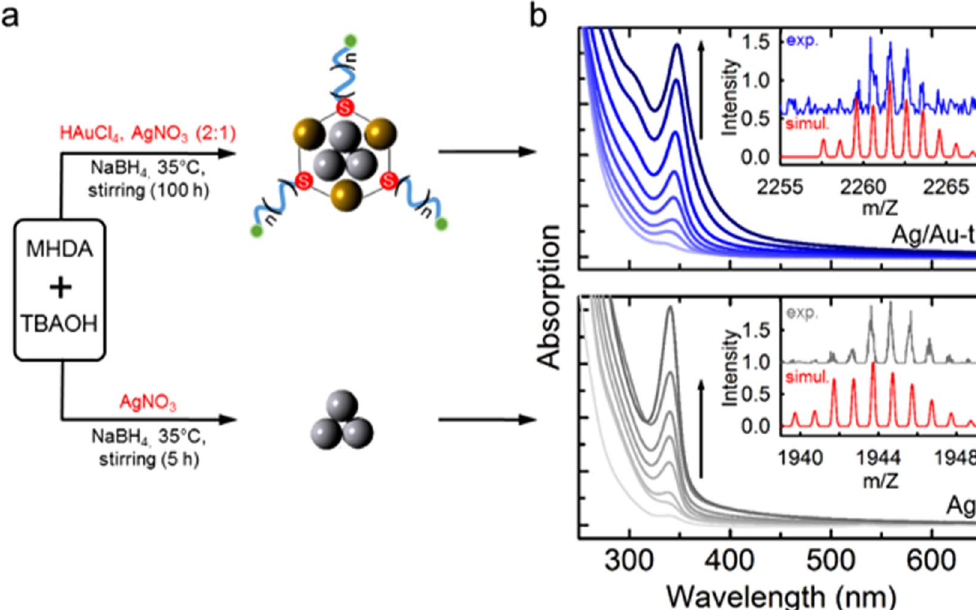
Figure 1. ( a ) Synthesis routes for the preparation of Ag clusters protected by Au-thiolate complexes (Ag/Au-t, top panel) and bare Ag clusters (bottom panel). In the schematic depictions of the two systems, the green circles correspond to carboxylic end-groups and the subscript n = 7. The molecular surfactants (tetrabutylammonium, TBA and 16-mercaptohexadecanoic acid, MHDA) are omitted for clarity. ( b ) Absorption spectrum of Ag/Au-t and Ag clusters aliquots of the reaction medium as function of time. The insets show the experimental and simulated isotopic mass distribution patterns of [Ag 3 Au 3 (MHDA) 3 (TBA) 2 H 2 ] + and [Ag 3 (MHDA) 2 (TBA) 4 (NO 3 ) O] + chemical species for the protected and bare clusters,